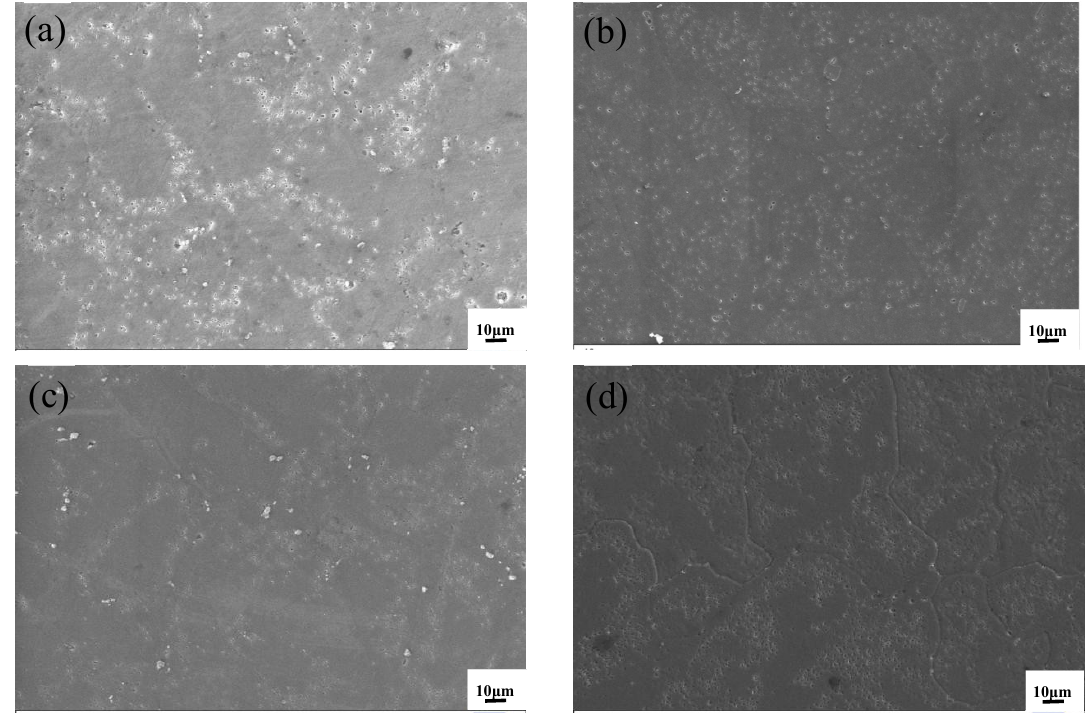
Figure 4. Microstructure of the alloys after aging: ( a ) ZL205A alloy, ( b ) ZL205A + 0.1%La alloy, ( c ) ZL205A + 0.3%Al–5Ti–0.8C alloy, and ( d ) ZL205A + 0.1%La + 0.3%Al–5Ti–0.8C